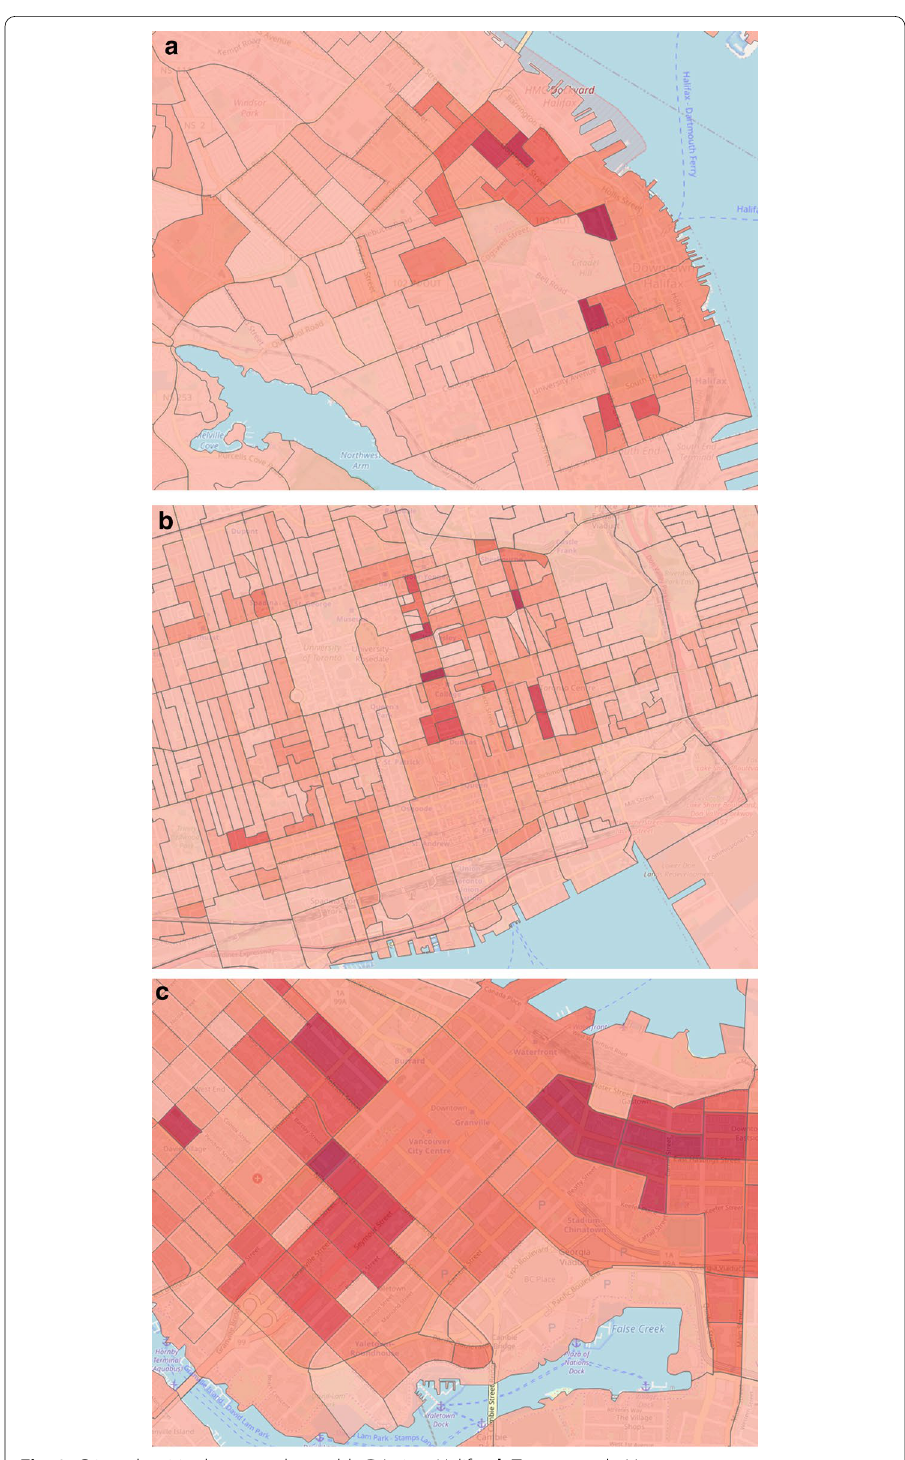
Fig. 2 Crime densities by most observable DAs in a Halifax, b Toronto and c